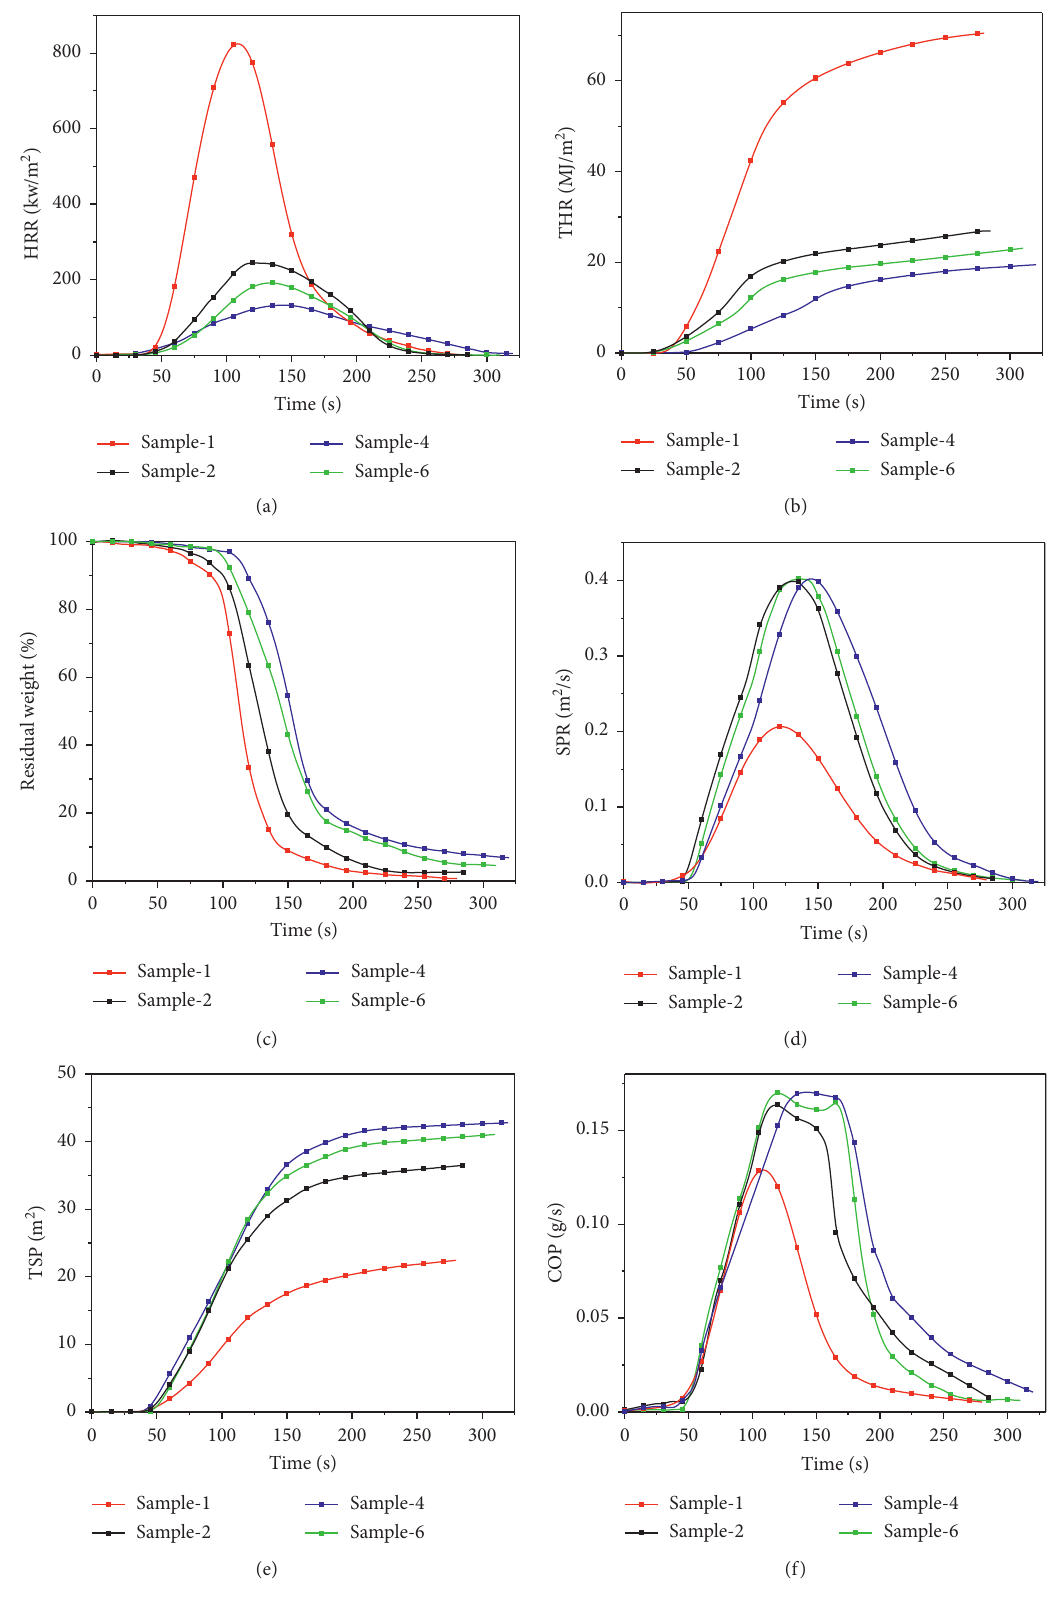
Figure 5: HRR (a), THR (b), ML (c), SPR (d), TSP (e), and COP (f) curves of HIPS and the